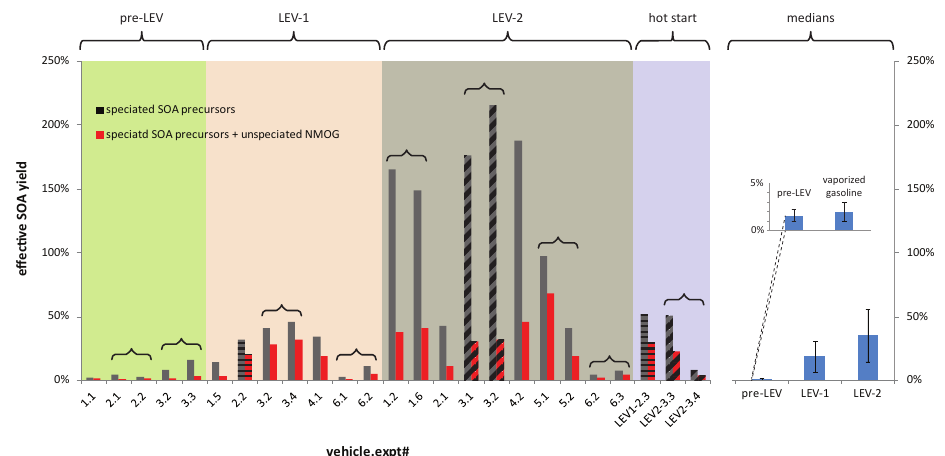
Fig. 7. Two different effective SOA yield estimates (after 3h of photooxidation) for pre-LEV, LEV1 and LEV2 light-duty gasoline vehicles ( n = 25). The grey bars represent yields assuming only traditional (speciated) SOA precursors; the red bars also include unspeciated NMOG in the effective yield calculations. The braces indicate nine sets of duplicate experiments. Hot-start and normal UC driving cycle experiments were performed with two vehicles (LEV1-2 and LEV2-3), denoted by the horizontal and diagonal black lines inside of the bars, respectively. Median ( ± 1 σ ) effective SOA yields for the three LEV classes are shown on the right side. The inset compares the SOA yield for vaporized gasoline (error bar represents the range of values measured for 1µgm − 3 < C oa < 10µgm − 3 ) from Jathar et al. (2013) with the yield from the pre-LEV emissions. Multiple experiments with the same vehicle were averaged before medians were